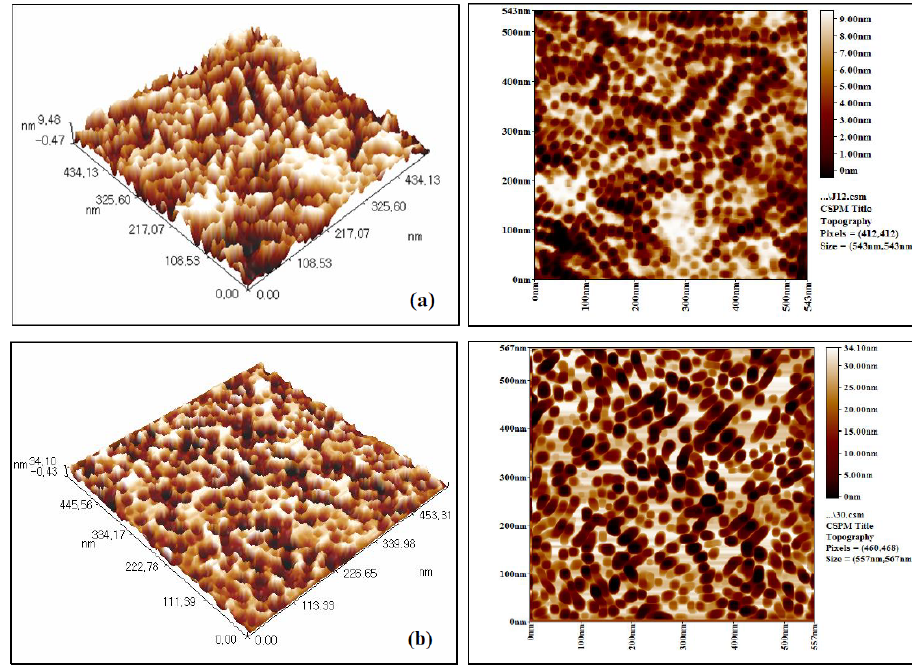
Figure 4: Illustrated the 2-D and 3-D AFM images (a) at J= 12 and (b) J= 30 mA/cm 2 , HFc 40%, and etching time 10 mints.